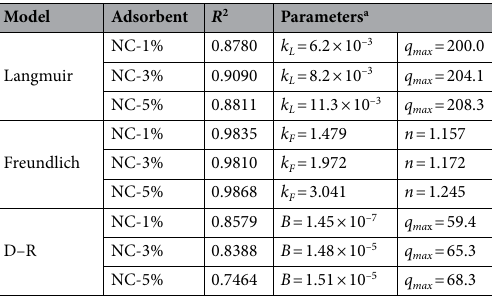
Model Adsorbent R